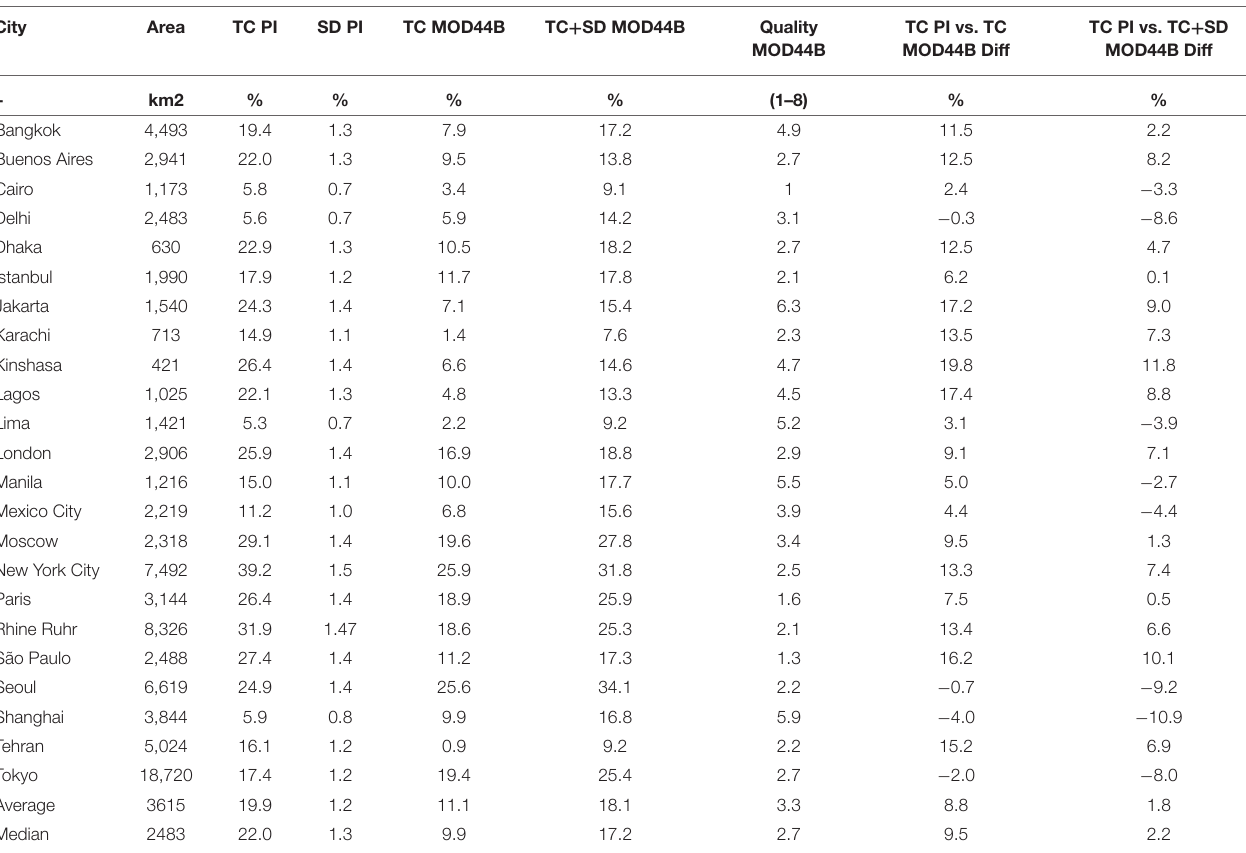
TABLE 2 | Megacity metropolitan area (km 2 ) and city-wide photo-interpreted (PI) tree cover (TC) percent (%), PI TC standard error, MOD44B TC_1 without its standard deviation, MOD44B TC_2 with its standard deviation, MOD44B quality on a scale of 0 to 8, with 0 best and 8 worst, difference between PI TC and MOD44B TC_1 (%), and difference between PI TC and MOD44B TC_2